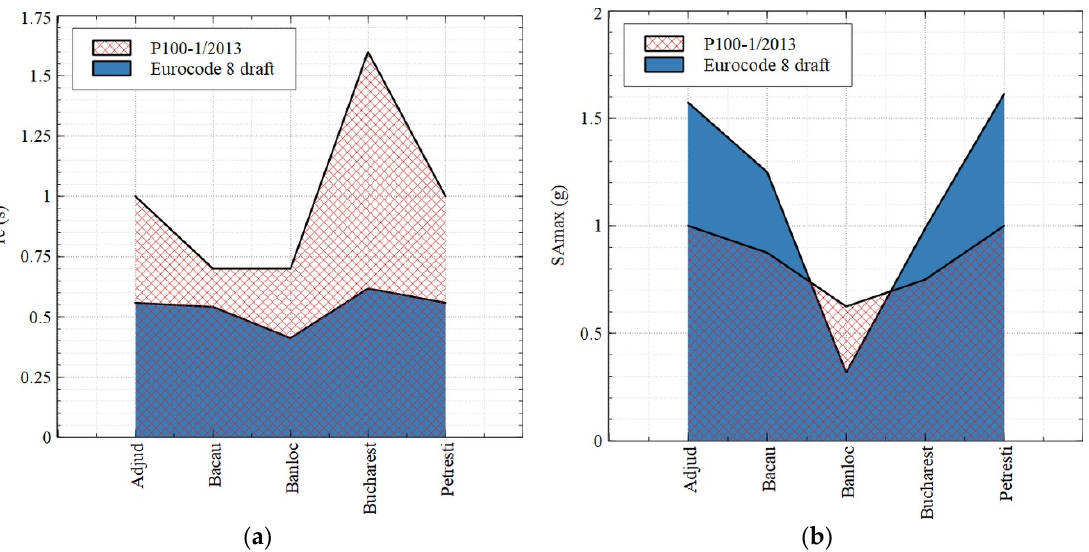
Figure 6. ( a ) A comparison between the control period T C from P100-1/2013 [29] and based on Eurocode 8 draft revision [1] for category F sites; ( b ) a comparison between the maximum spectral acceleration from P100-1/2013 [29] and based on Eurocode 8 draft revision [1] for category F sites.